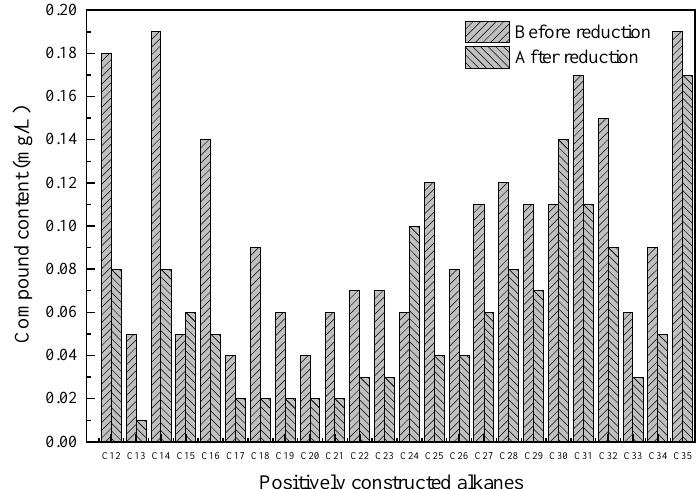
Figure 6. Compound content of positively constructed alkanes before and after reduction.